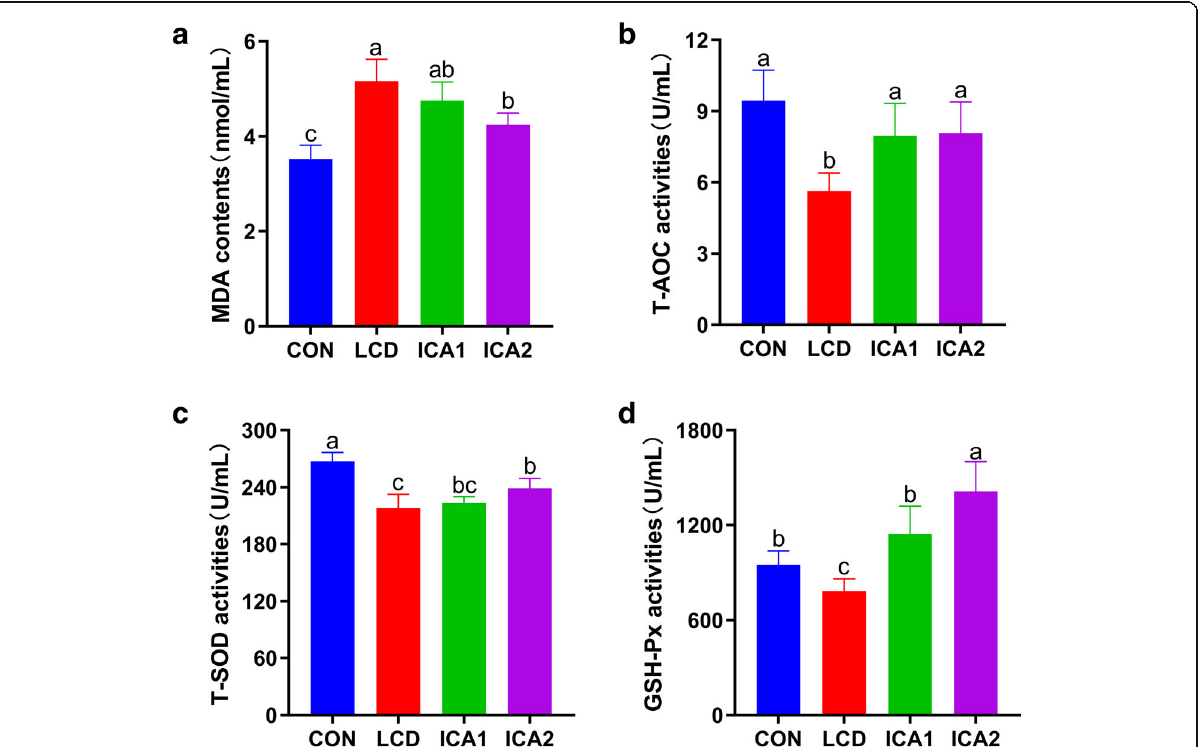
Fig. 4 Effects of ICA supplement on serum redox state. a Contents of MDA. b Activities of T-AOC. c Activities of T-SOD. d Activities of GSH-Px. MDA, malondialdehyde. T-AOC, total antioxidant capacity. T-SOD, total superoxide dismutase. GSH-Px, glutathione peroxidase. ICA, icariin. CON, basal diet. LCD, low calcium diet. ICA1, low calcium diet supplied with 0.5 g/kg ICA. ICA2, low calcium diet supplied with 2.0 g/kg ICA. Data are presented as the mean ± SD ( n = 6). Means in each column with different alphabetic letters are significantly ( P < 0.05) different